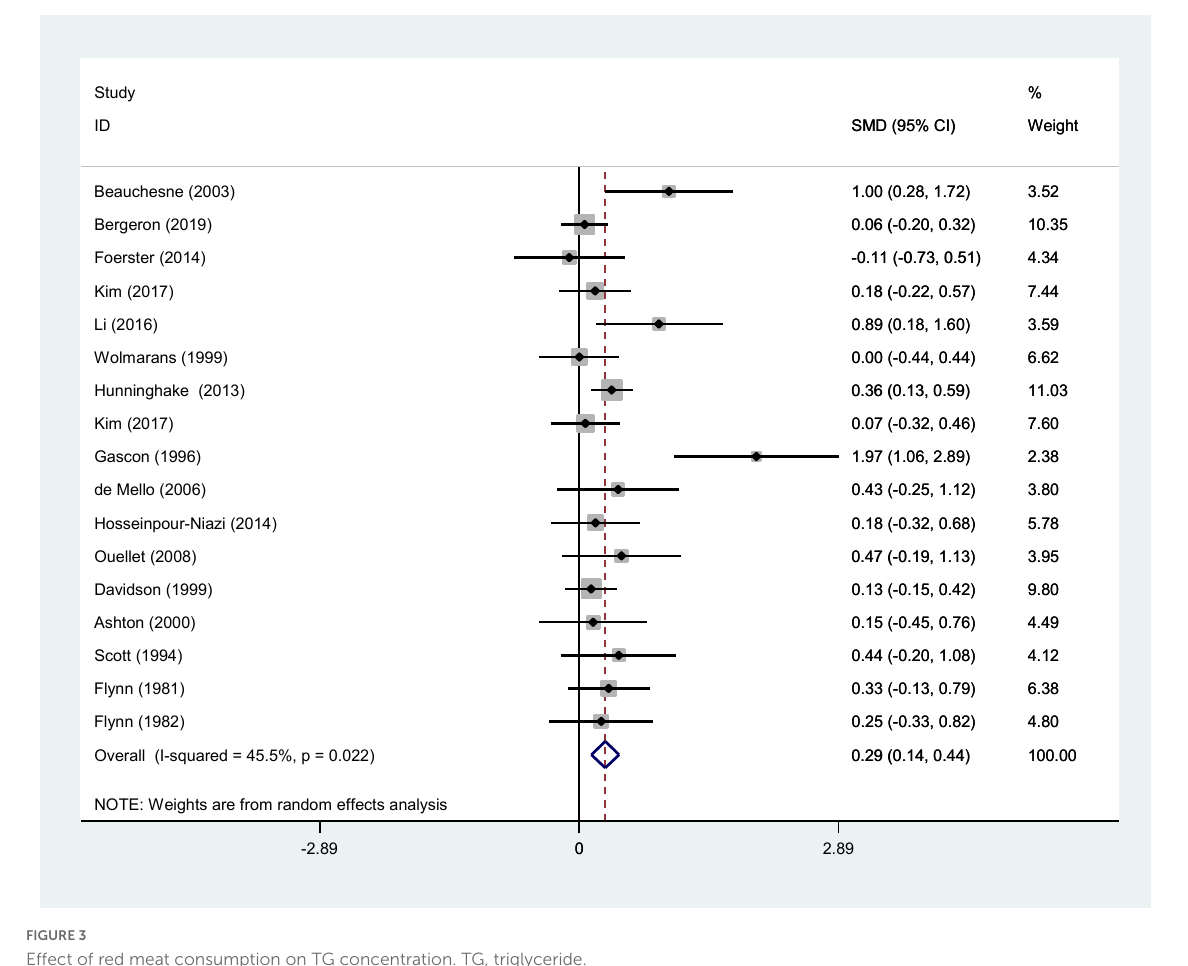
FIGURE3 Effect of red meat consumption on TG concentration. TG,